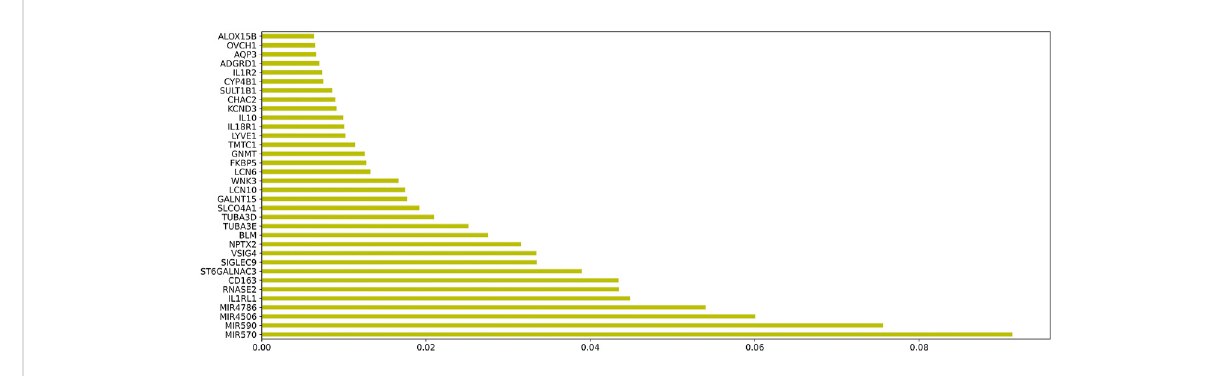
FIGURE 8 The histogram of the Top 50 genes and their corresponding weights in module 12.